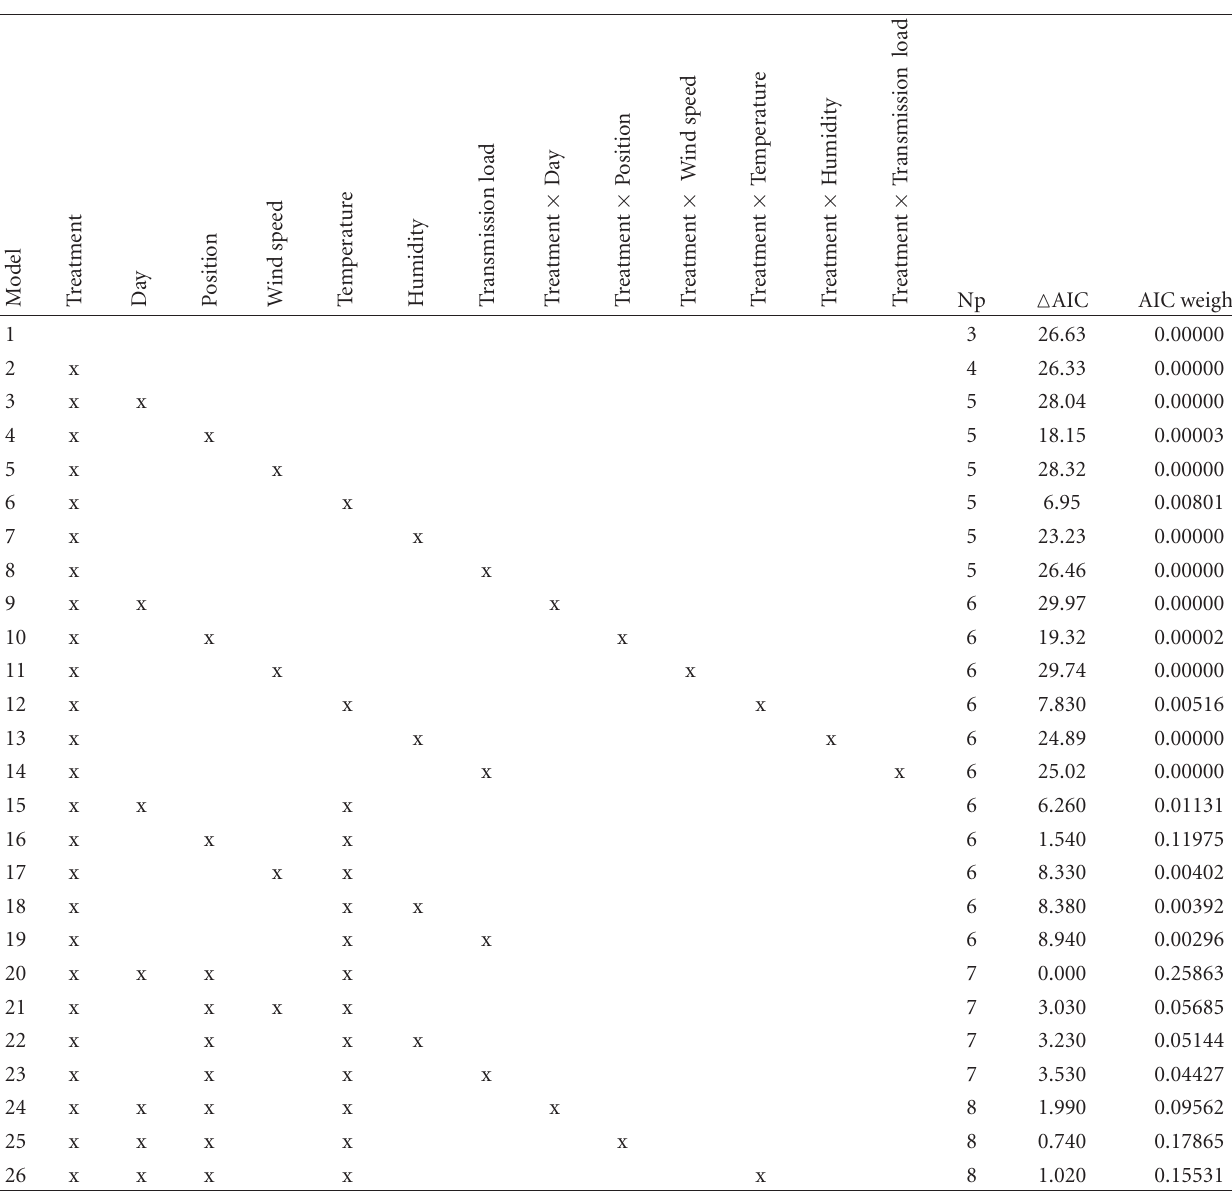
Table 8: Results from model selection on number of activity changes/minute among domestic wild animals using the AIC criterion (Np is number of parameters).